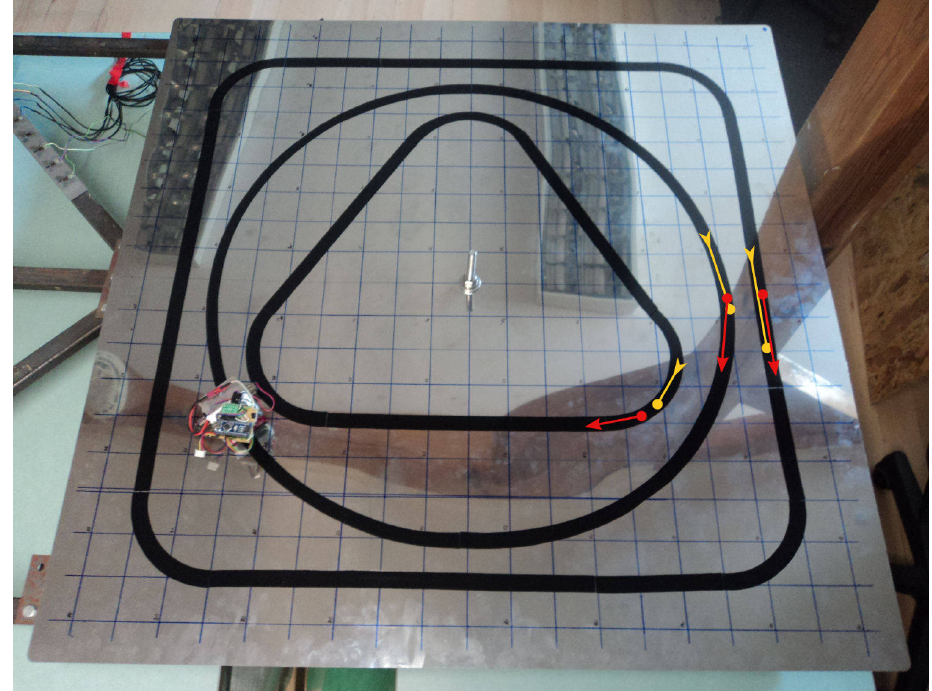
Figure 2. The laboratory test stand: a 1 m × 1 m × 0.5 mm steel plate with a line-follower robot and three test trajectories. The beginning and the end points of each trajectory are marked with red and yellow arrows, respectively. The square and circle trajectories were covered twice, while the triangle trajectory was covered three